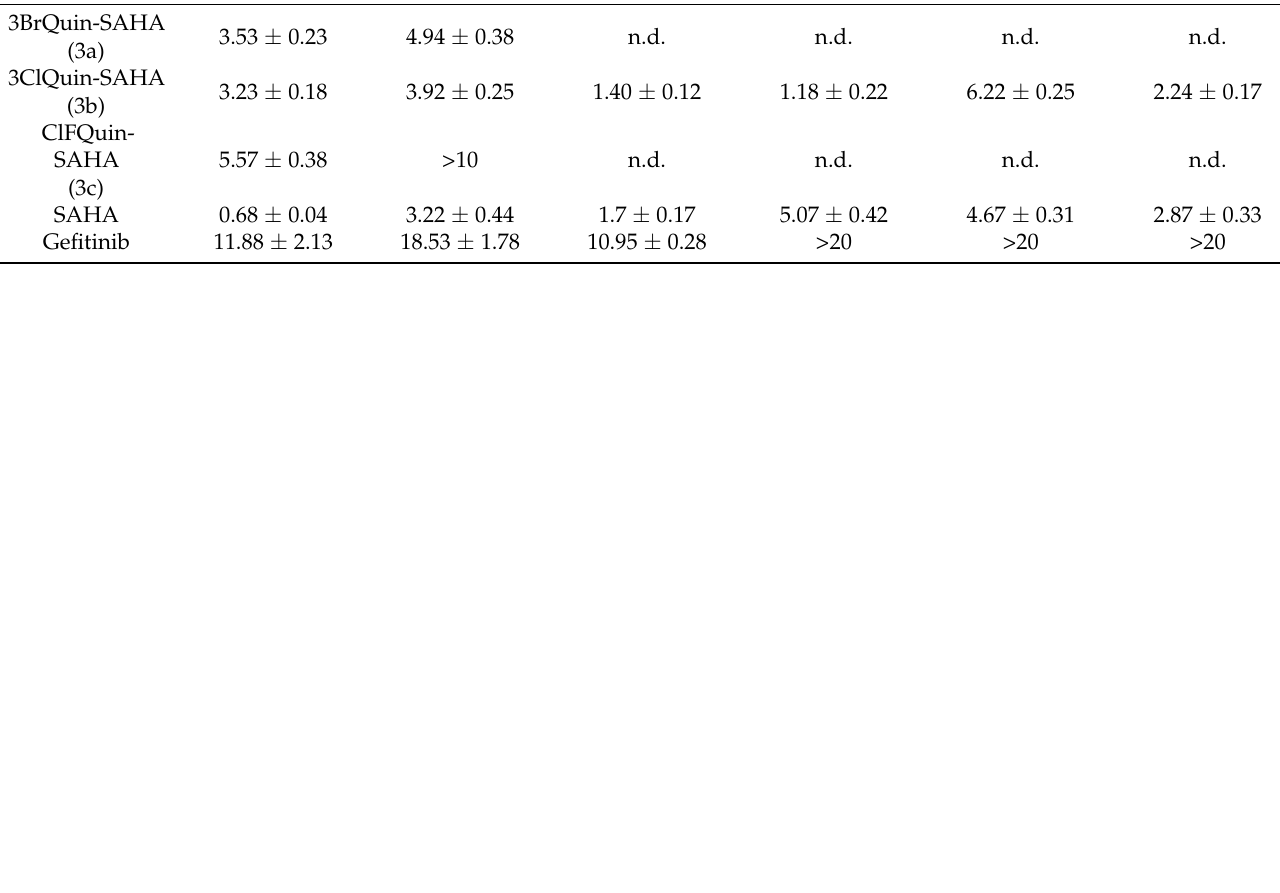
Table 1. Growth-inhibitory activity expressed as IC 50 ( µ M) of novel chimeric inhibitors in human prostate cancer (DU145), hepatoma (Hep-G2), and human T-cell lymphoma cell lines, as determined after 48 h. SAHA and gefitinib were used as clinically relevant references for monomodal HDAC- or EGFR-inhibition, respectively. All results are described as means ± SEM of n ≥ 3 (for sensitive) or n = 2 (for insensitive compounds) independent experiments.